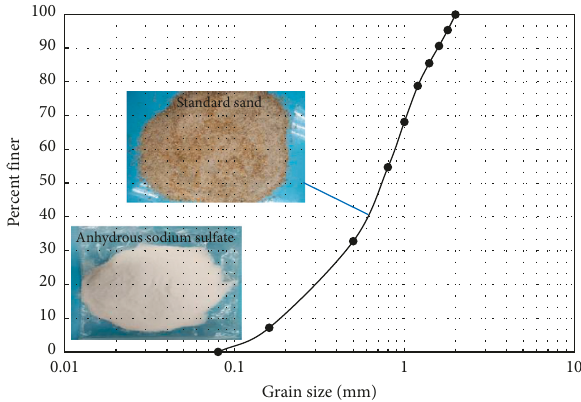
Figure 2: Grain size distribution for standard test sand. Table 1: Ratio of sulfate saline soil.